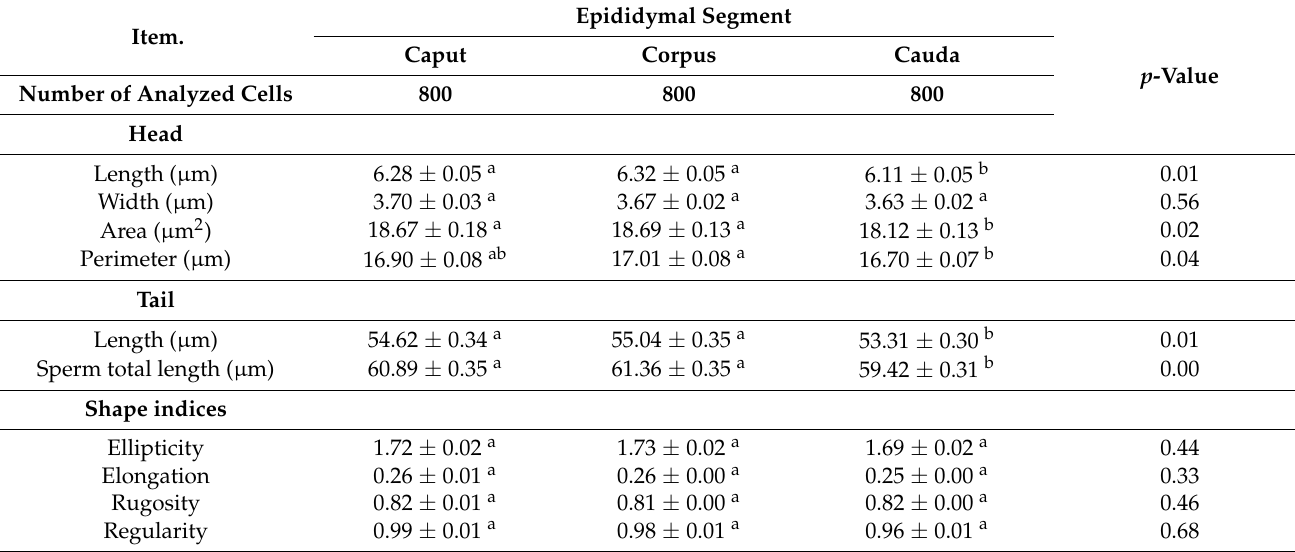
Table 1. Sperm morphometry in each segment of the epididymides of dogs (mean ± SEM). Epididymal Segment Item. -ValueCaput